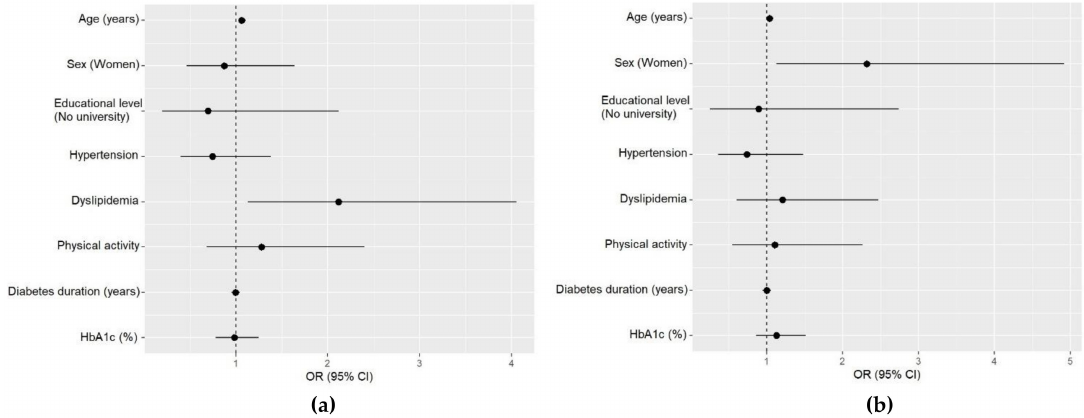
Figure 2. Multivariable analyses for the alternate Mediterranean Diet (aMED) score and alternate Healthy Eating Index (aHEI) of participants with type 2 diabetes. ( a ) Multivariable logistic regression for the high tertile (6–9 points) of the aMED. Hosmer–Lemeshow test p < 0.001; ( b ) multivariable logistic regression for the high tertile ( ≥ 46 points) of the aHEI. Hosmer–Lemeshow test p <